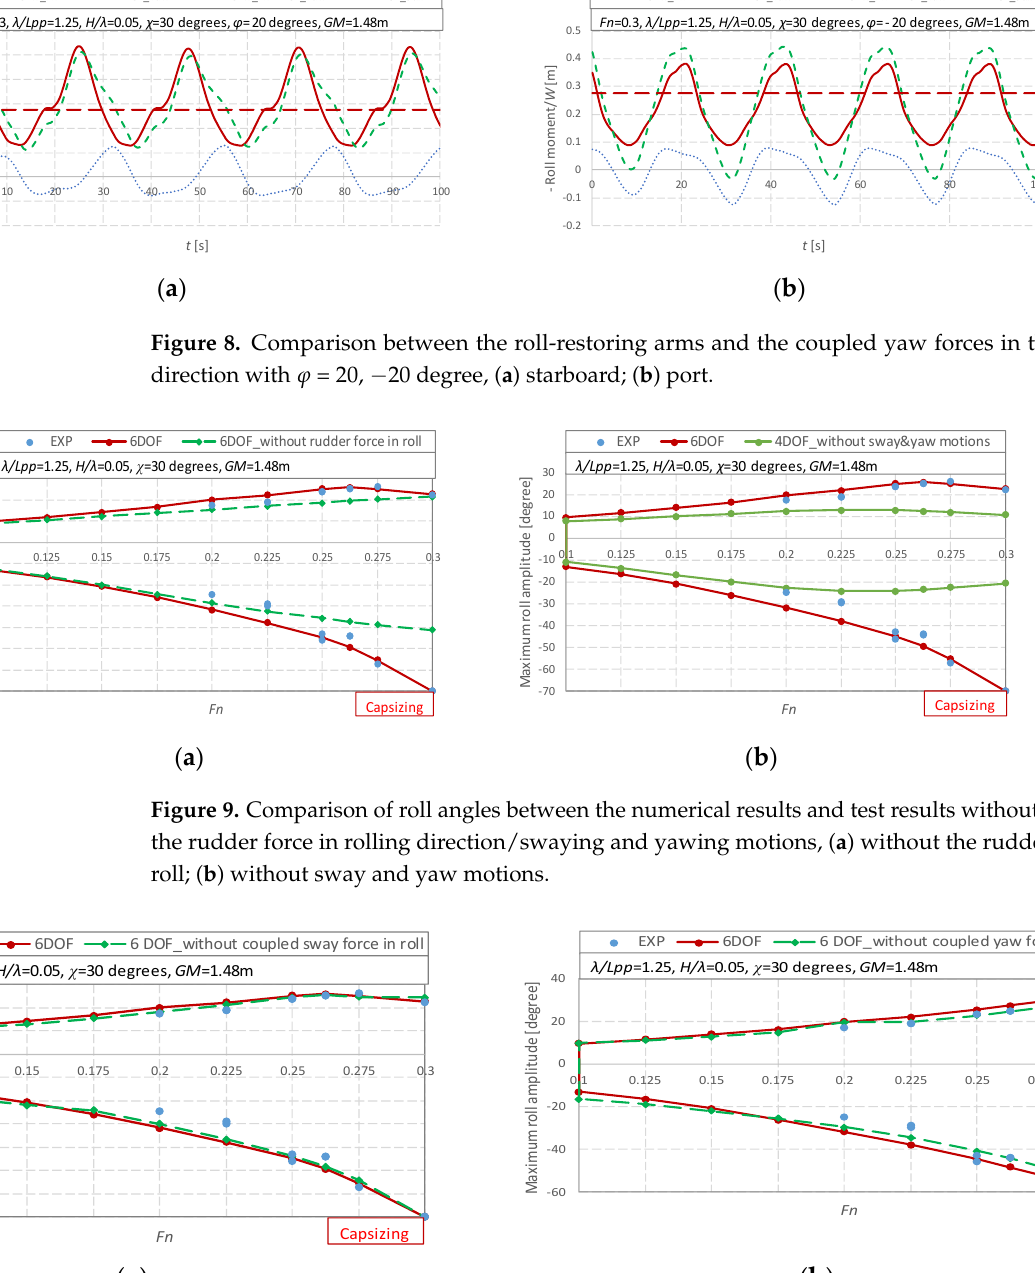
direction with φ = 20, −2 0 degrees, ( a ) starboard; ( b ) port.